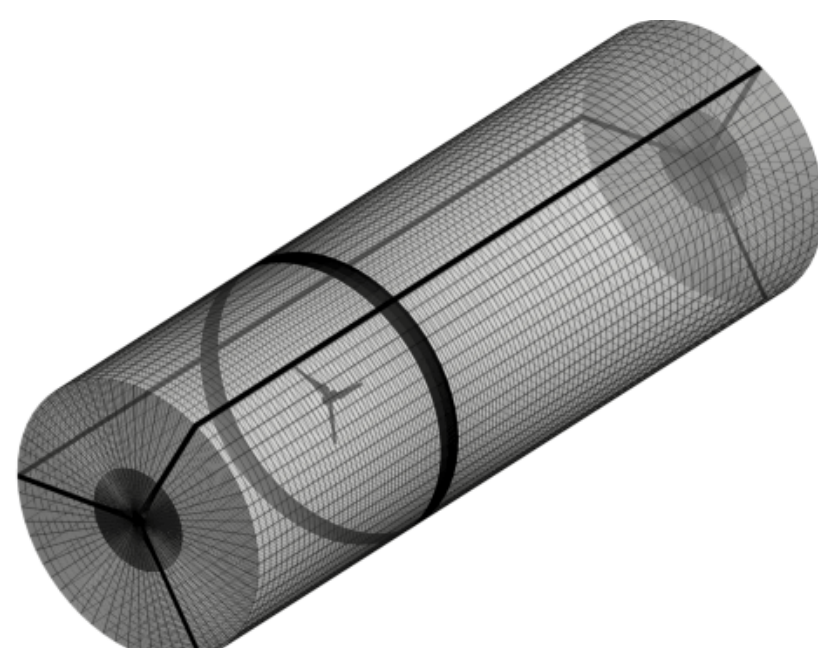
Figure 8. Computational mesh used in the present